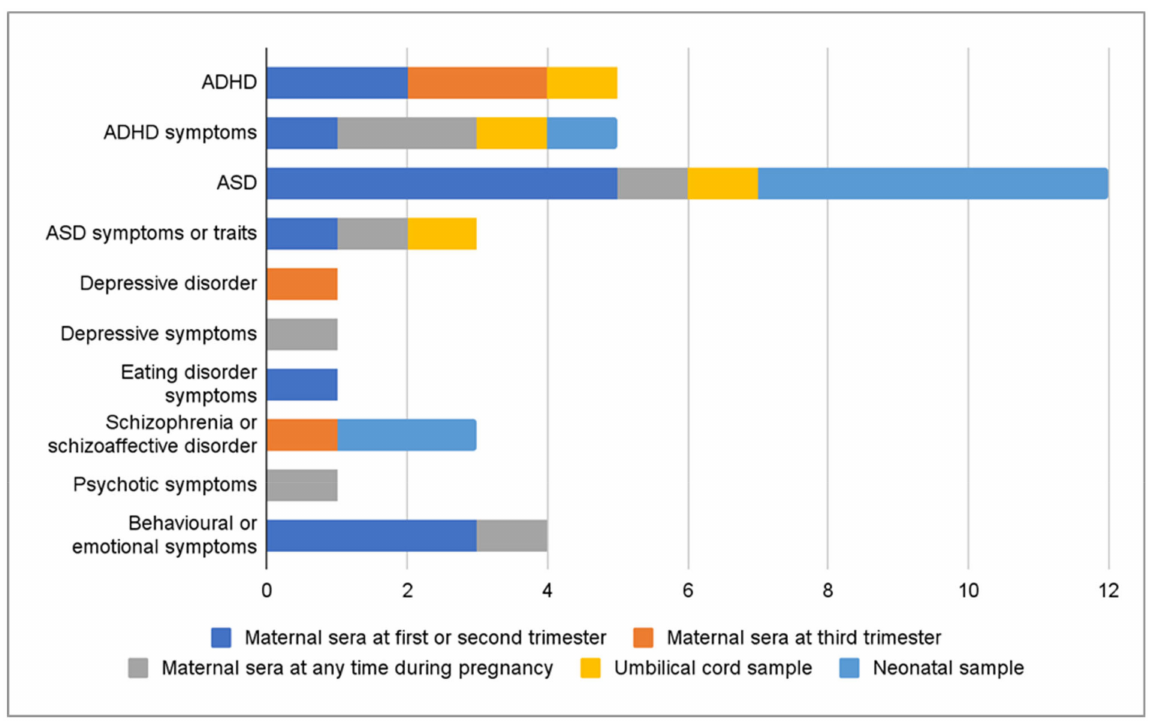
Figure 3. The number of studies for each outcome, stratified by vitamin D assessment time points in the study. Four studies assessed vitamin D at multiple time points.